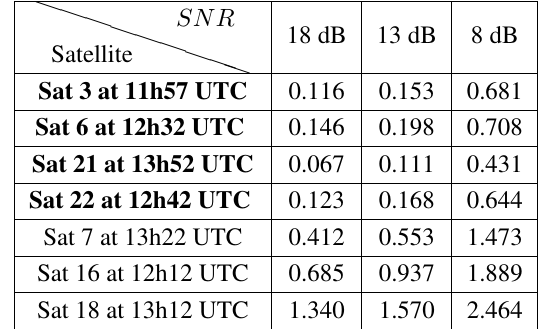
Table 3. RMSE of the estimated height ˆ h , in meters, for an observation interval of 150 s. = Reference height h = 2 m and α W